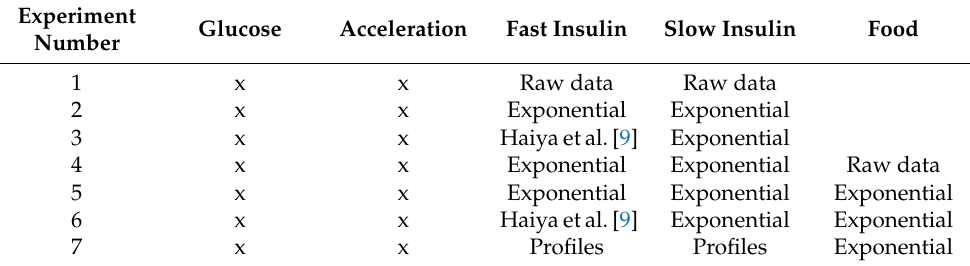
Table 5. Tries with different model